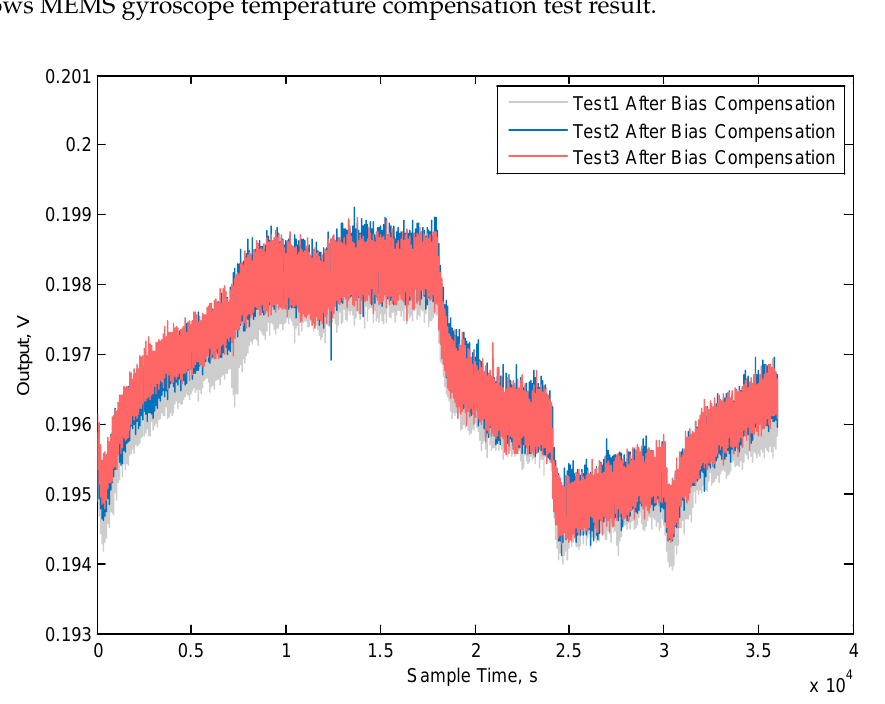
Figure 12. MEMS gyroscope bias before and after temperature compensation.